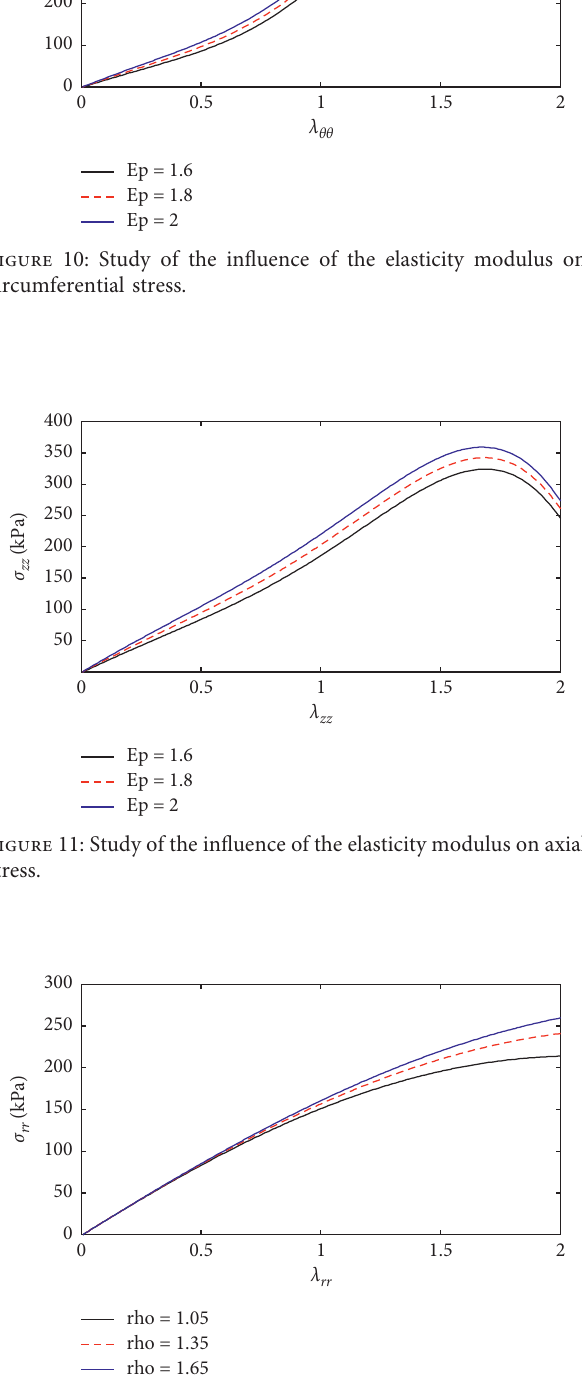
Figure 12: Influence of blood density on radial